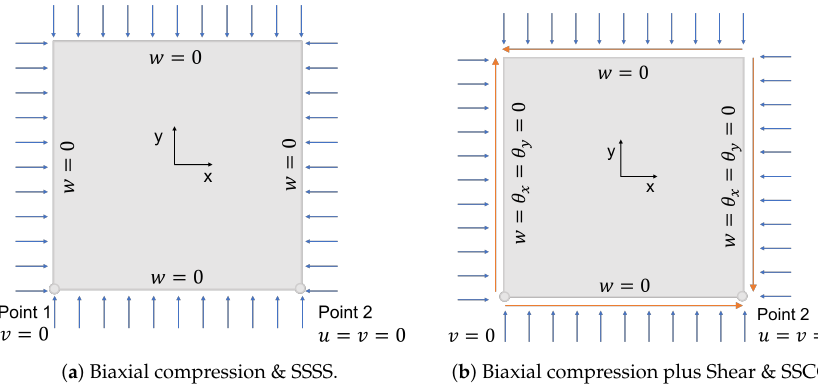
Figure 9. Two combinations of load cases and boundary